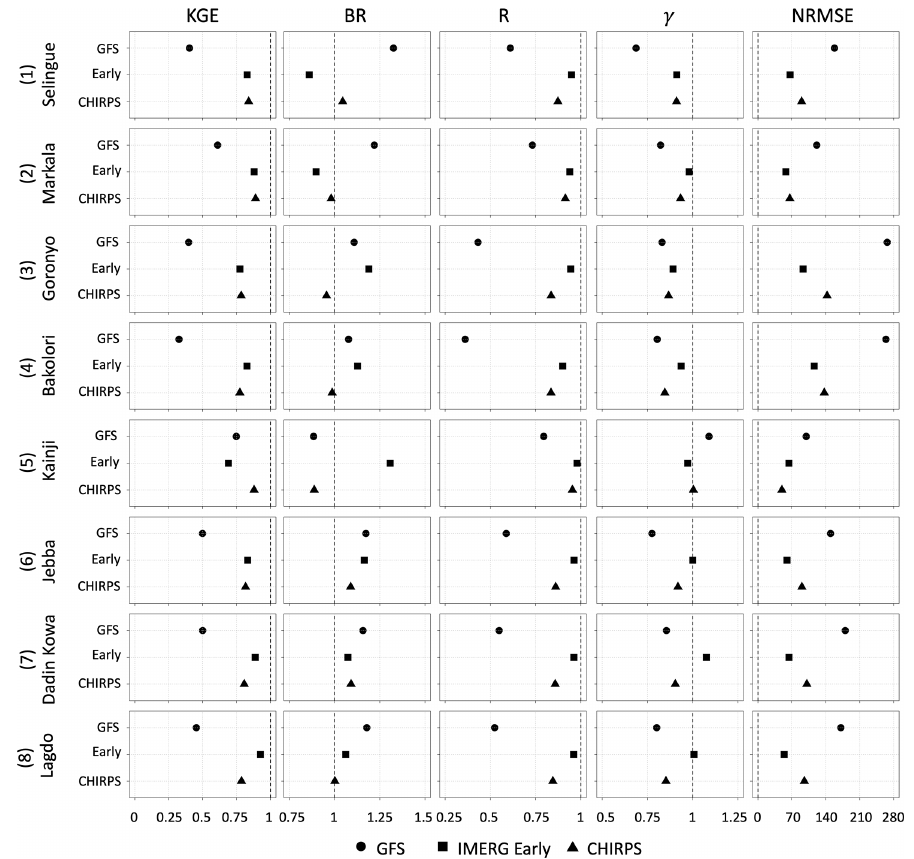
Figure 7. Summary of performance statistics (Kling–Gupta efficiency, KGE, bias ratio, BR, correlation, R , variability ratio, γ , and root mean square error normalized (NRMSE) by reference rainfall (percent) for the 1d lead time GFS forecasts and other satellite products. The time period considered was 15 June 2019–15 June